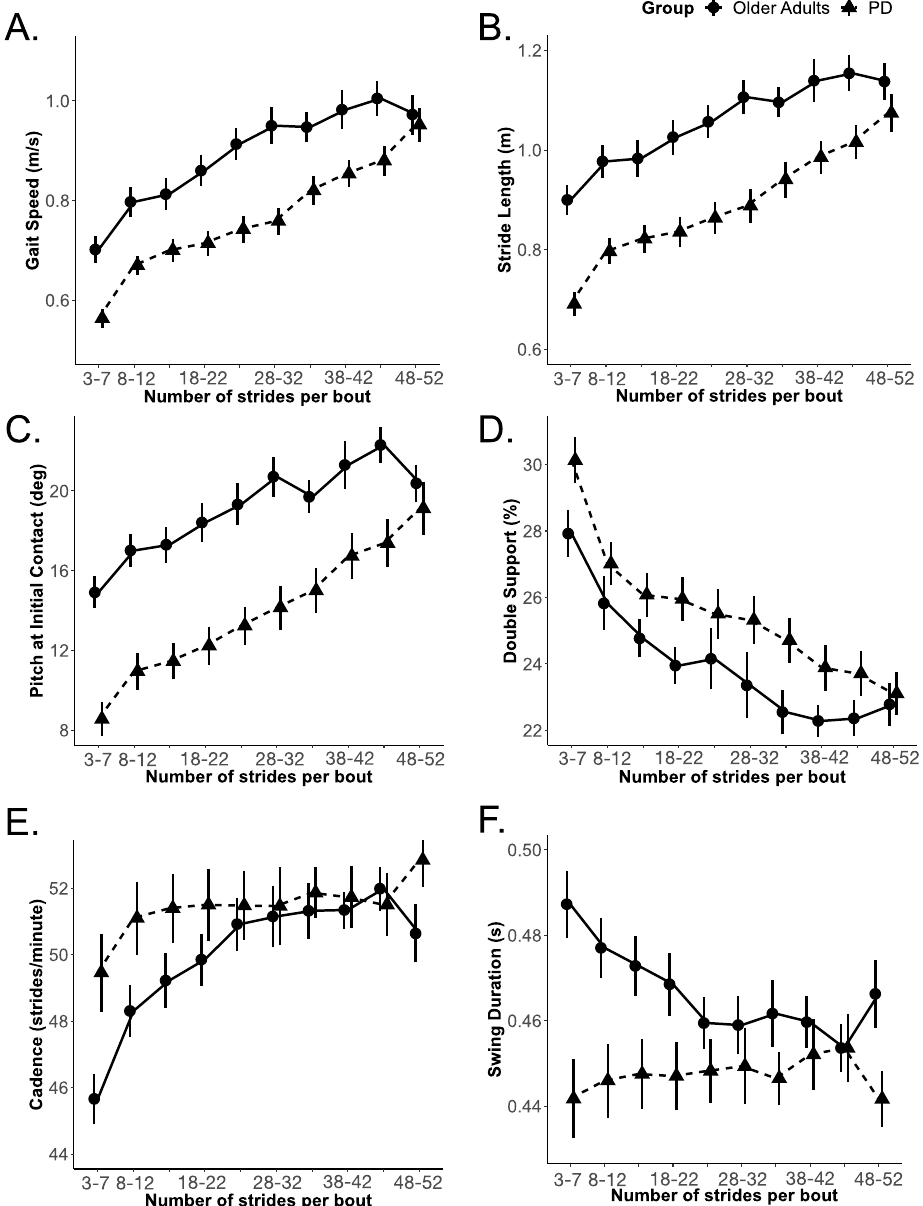
Figure 2. Gait measures (with a mean and standard error of the mean) as a function of bout length for OA and PD; ( A ) Gait speed, ( B ) Stride length, ( C ) Pitch at initial contact , ( D ) Double support, ( E ) Cadence, and ( F ) Swing duration.